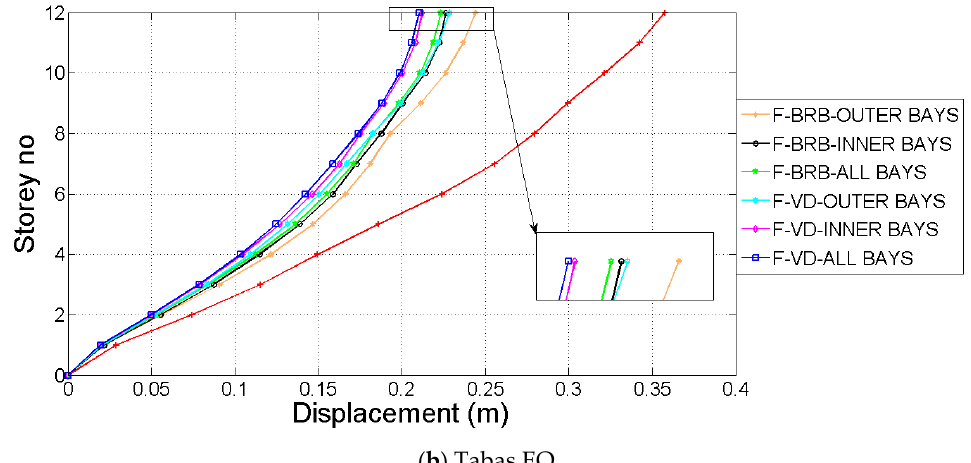
Figure 9. Variation of displacement with story level in 12-story frames.